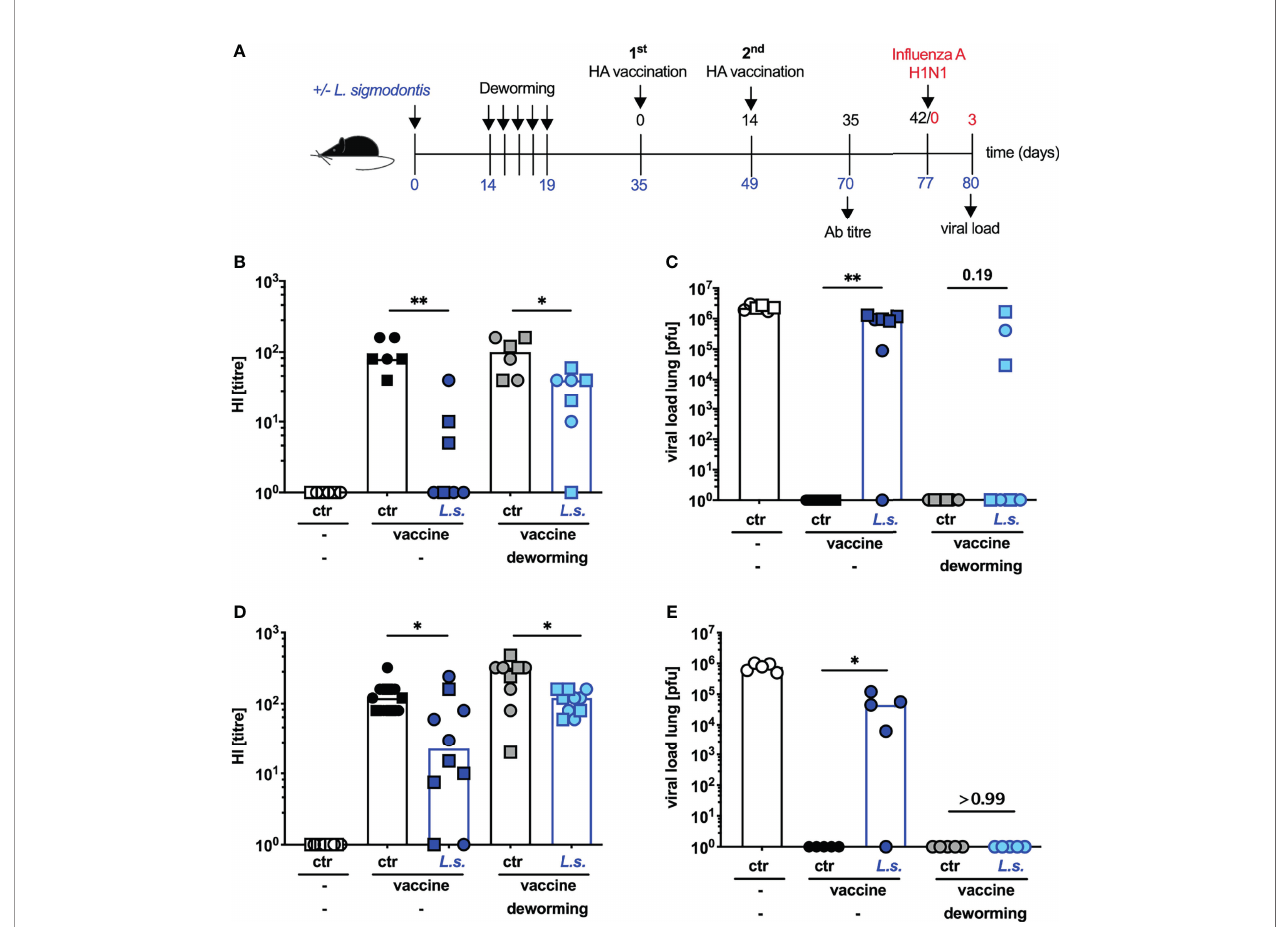
FIGURE 4 | Deworming 2 weeks before prime-boost vaccination with adjuvanted vaccine restores the ef fi cacy of vaccination against in fl uenza. (A) Experimental design: C57BL/6 mice were left naive (white, black and grey symbols) or naturally infected with L. sigmodontis (dark and light blue symbols). Mice received deworming treatment as a daily s.c. injection with 5 mg FBZ per kg body weight (grey and light blue symbols) for 5 consecutive days on day 14 p.i. – day 19 p.i. or were left untreated. Deworming ef fi cacy is shown in Supplementary Figure S1 . Mice were i.p. vaccinated with 3.75 µg in fl uenza vaccine either Begripal (B, C) or Fluad (D, E) on day 35 and day 49 post L. sigmodontis infection or were left unvaccinated (white symbols). (B, D) HI titres were quanti fi ed 21 days after the second vaccination. (C, E) All mice were i.n. infected with 1 x 10 3 PFU 2009 pH1N1 in fl uenza A virus 28 days after the 2 nd vaccination. In fl uenza virus burden in the lungs was quanti fi ed at day 3 post challenge infection. Shown are combined results from 2 experiments (B, C) or 1 experiment (D, E) with n ≥ 3 per group and experiment. Each symbol represents an individual mouse, squares, circles and triangles represent independent experiments, bars show the median and asterisks indicate statistically signi fi cant differences applying Mann-Whitney test (* p ≤ 0.05, ** p ≤ 0.01, numbers indicate p -values). ( L. sigmodontis , Litomosoides sigmodontis ; s.c., subcutaneous; FBZ, Flubendazole; p.i., post infection; i.p., intraperitoneal; HI, hemagglutination inhibition; i.n., intra nasal; PFU, plaque forming